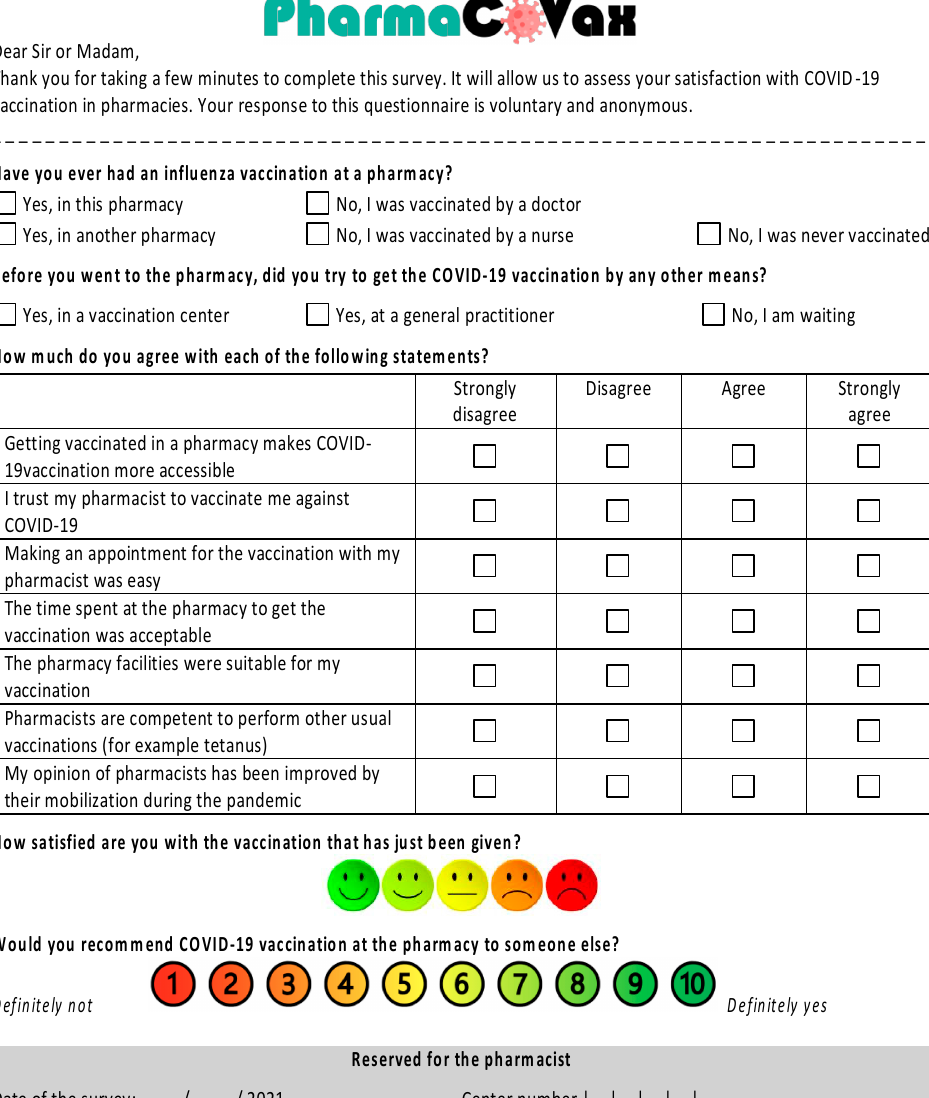
Figure A2. English Translation of PharmaCoVax Survey